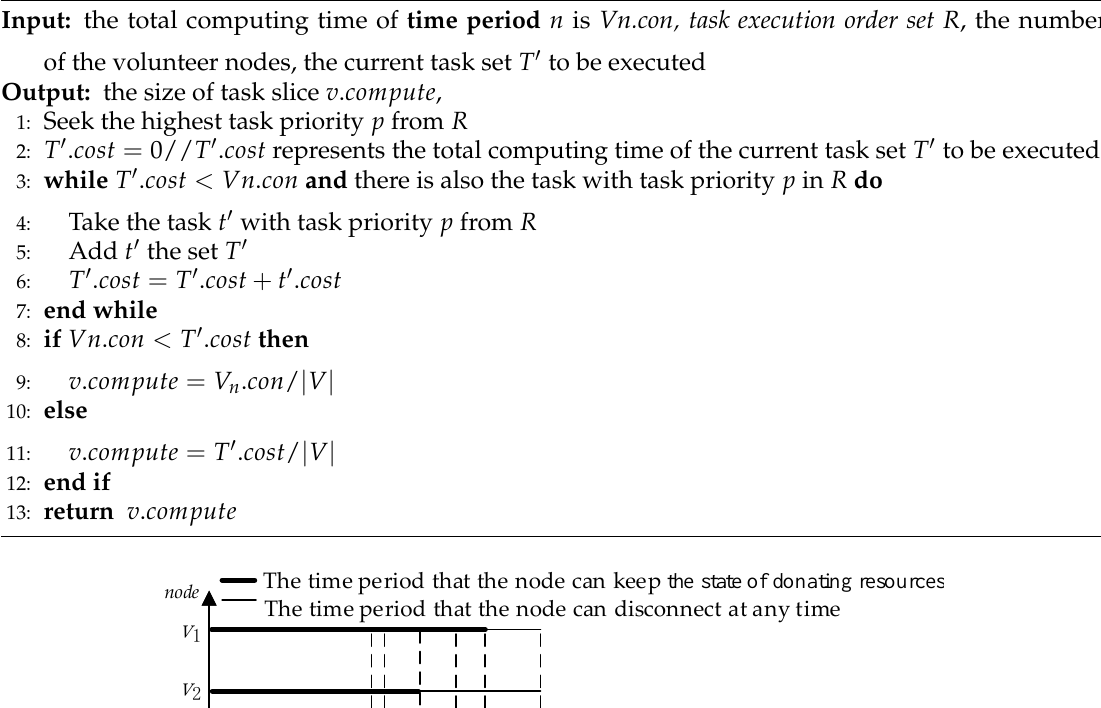
Algorithm 3 The task slice function ComTSet (Vn.con,R,|V|,T’)